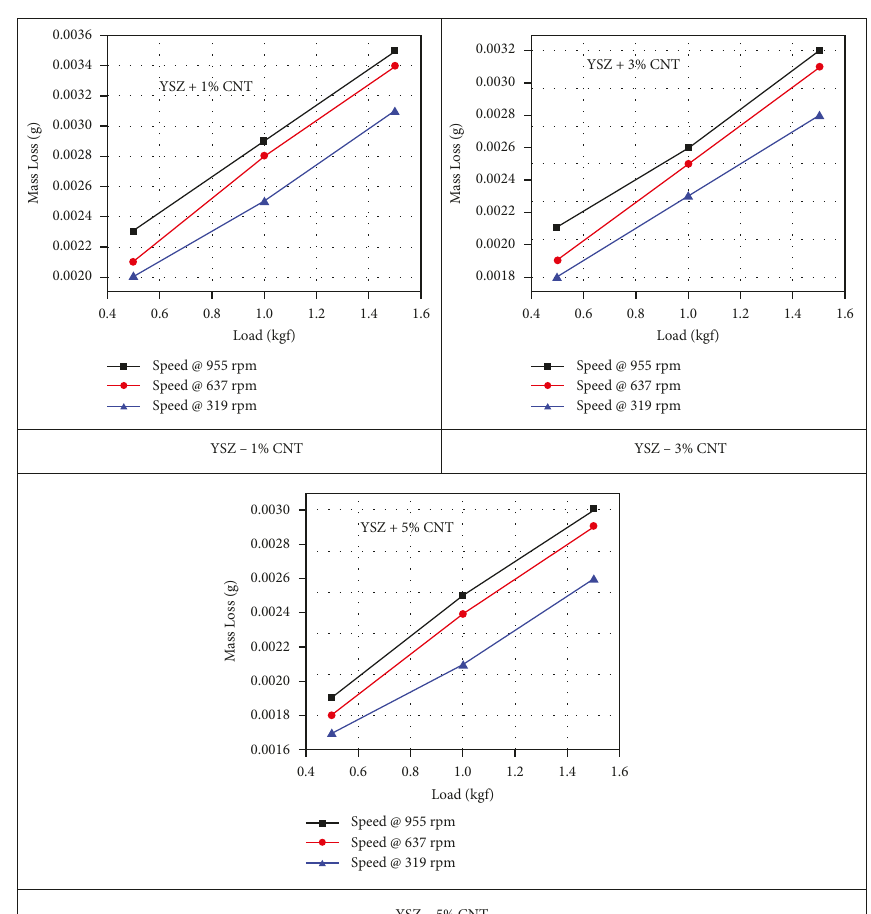
Figure 8: Mass loss measured during the experimentation with YSZ+CNT coating for different rotational